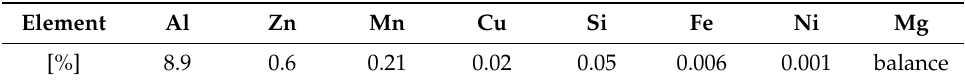
Table 1. Chemical composition of